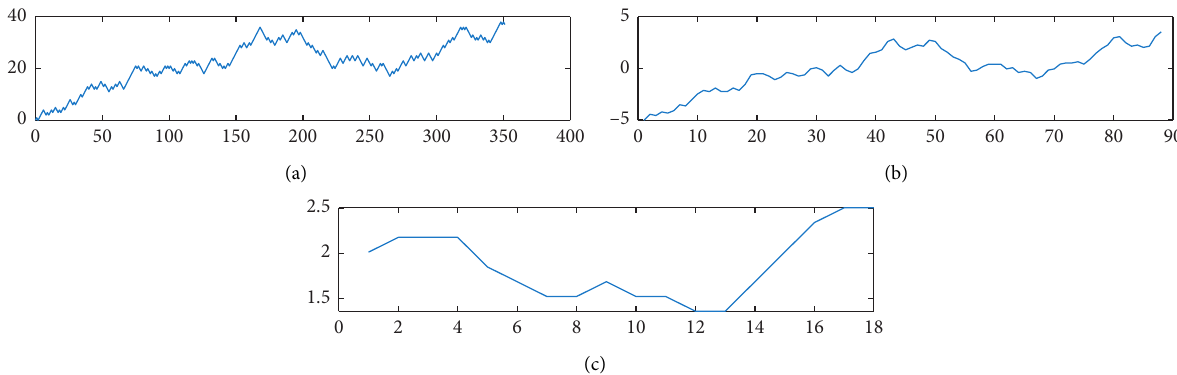
Figure 4: (a) Graphical representation of RNA secondary structure. (b) The third-level discrete wavelet transform. (c) The DFA fractal dimension of (b) obtained with a sliding window width of 17.